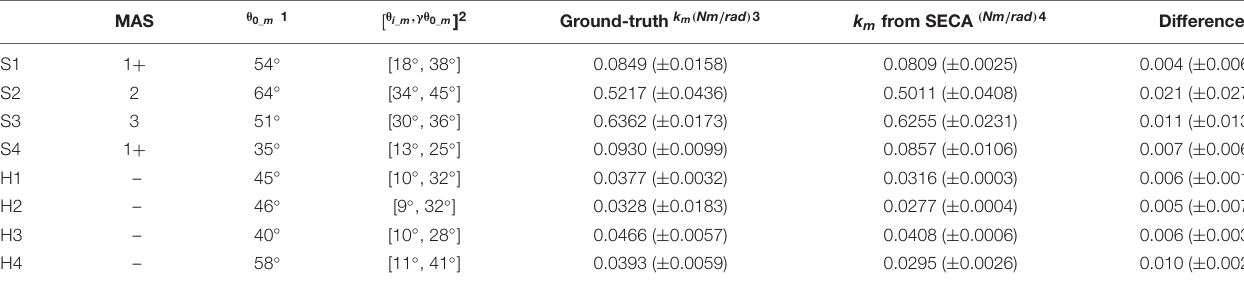
TABLE 2 | Summarization of MCP joint stiffness characteristic with different measurement